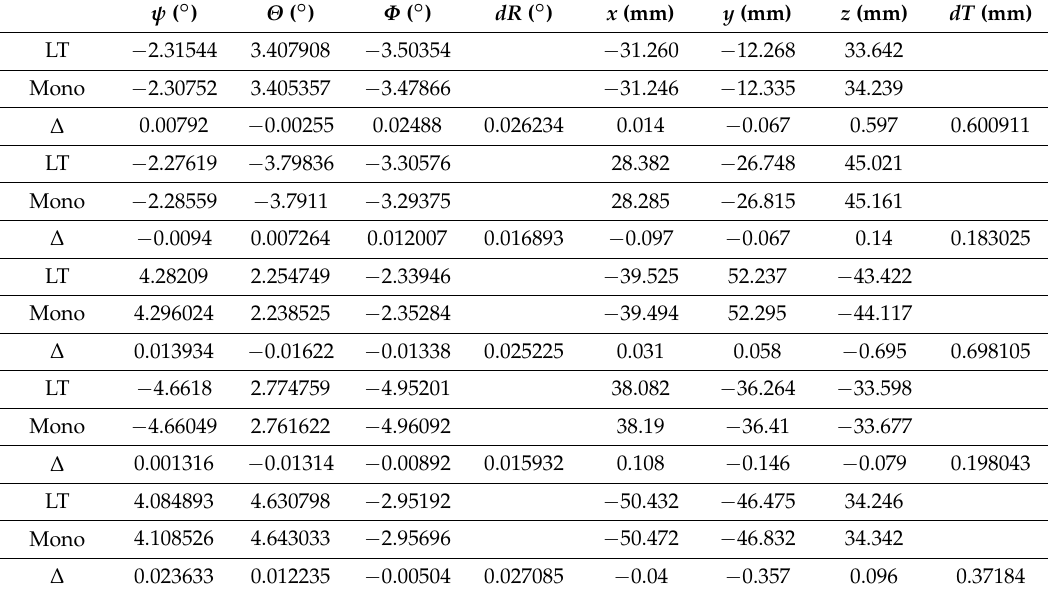
Table 3. Measured results compared with tracker.